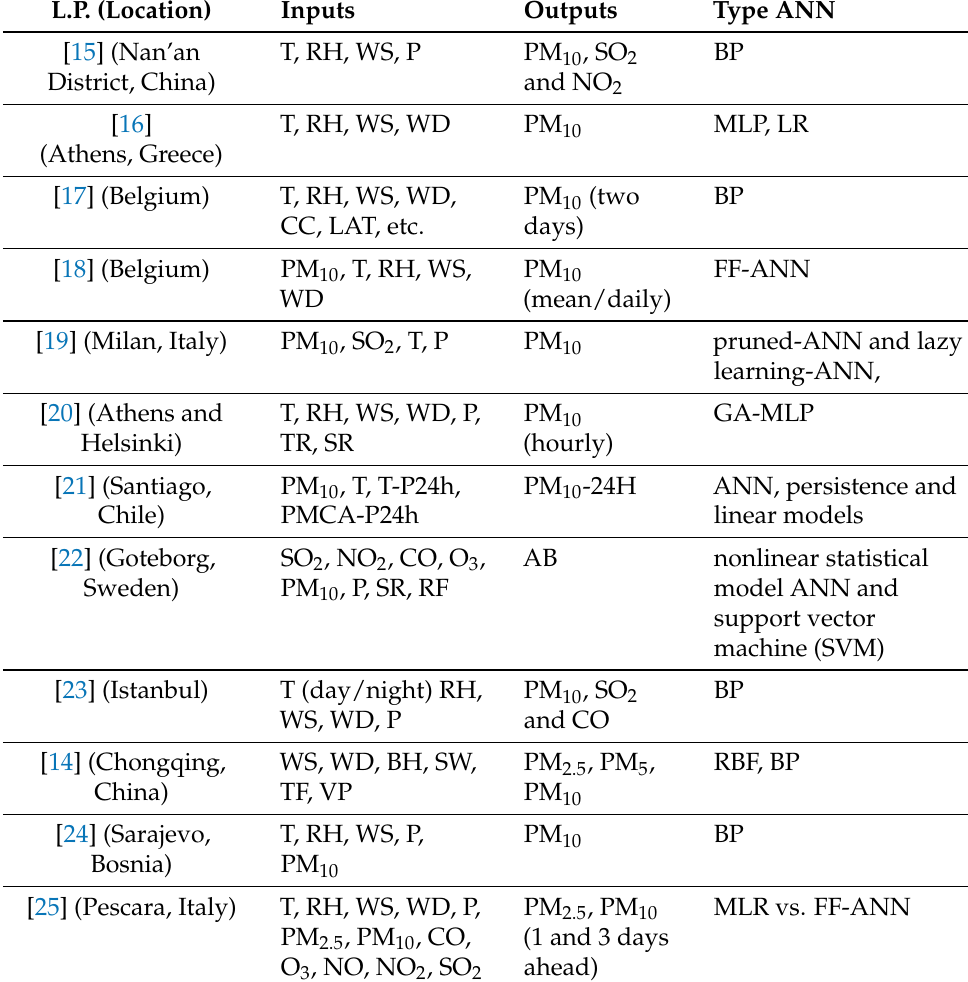
Table 1. Details of papers reviewed later in the text.